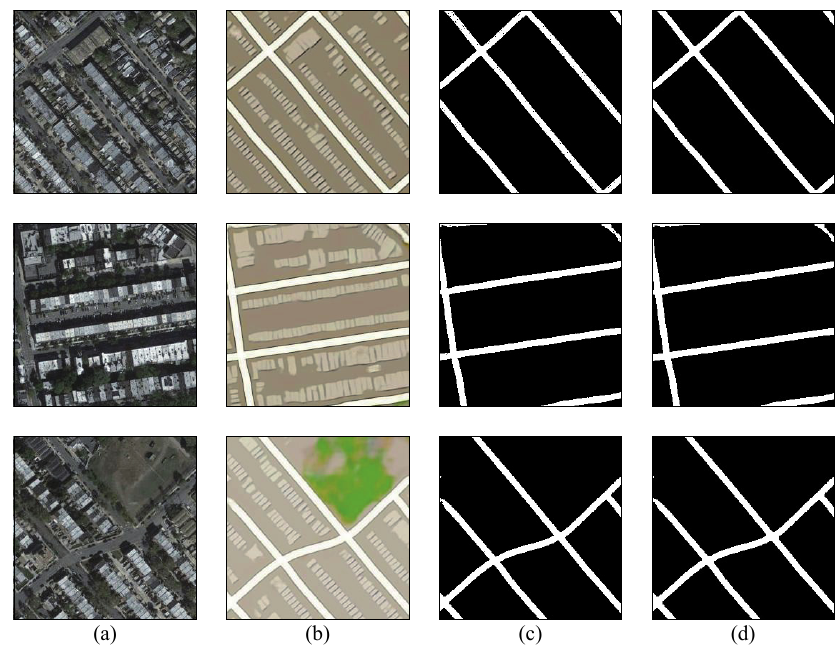
Figure 9. Results for the road network: ( a ) remote sensing images, ( b ) synthesis images, ( c ) binary images, and ( d ) denoised images.